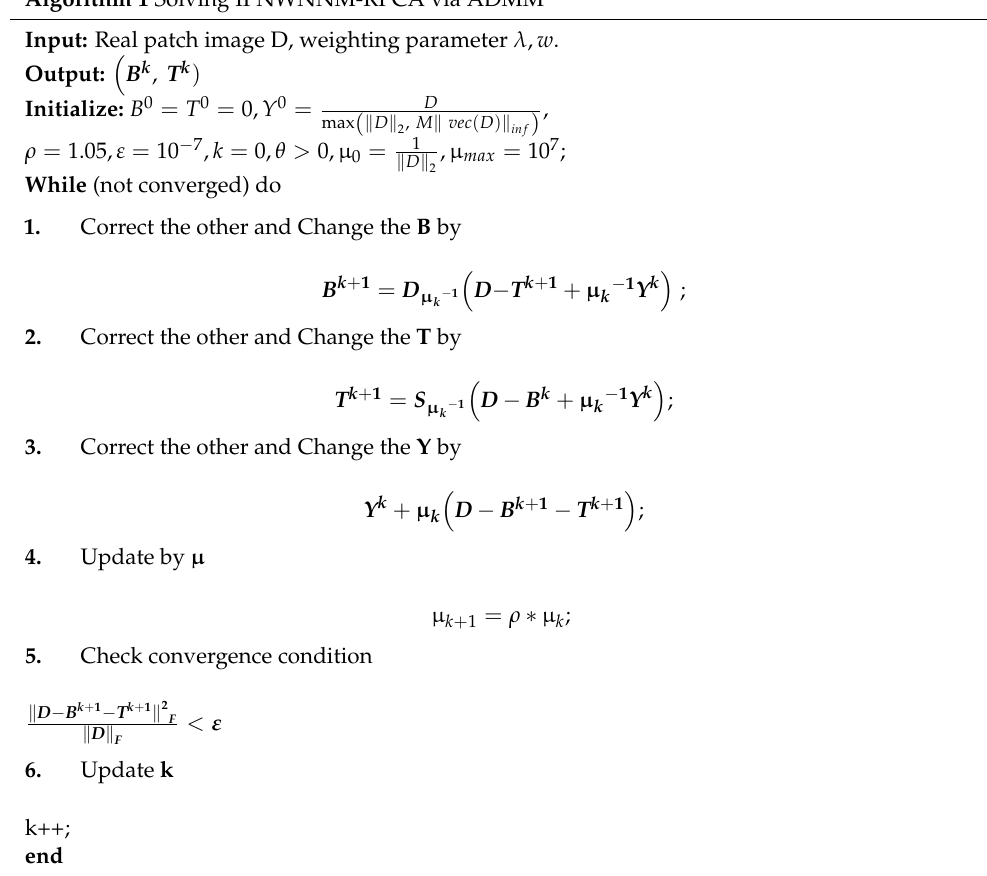
Table 3. Summary of the different parameters used in the evaluations.